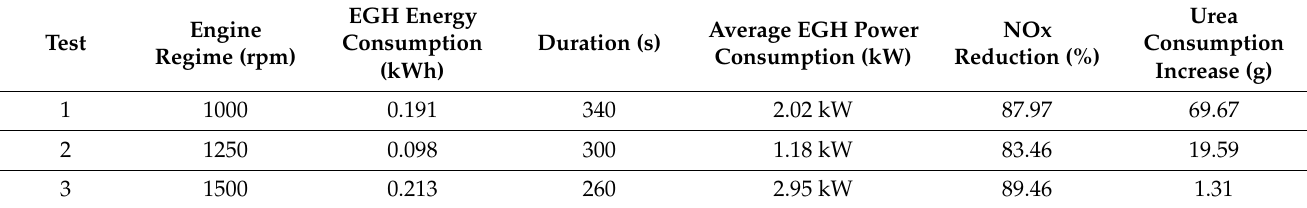
Table 2. EGH consumption and NOx reduction